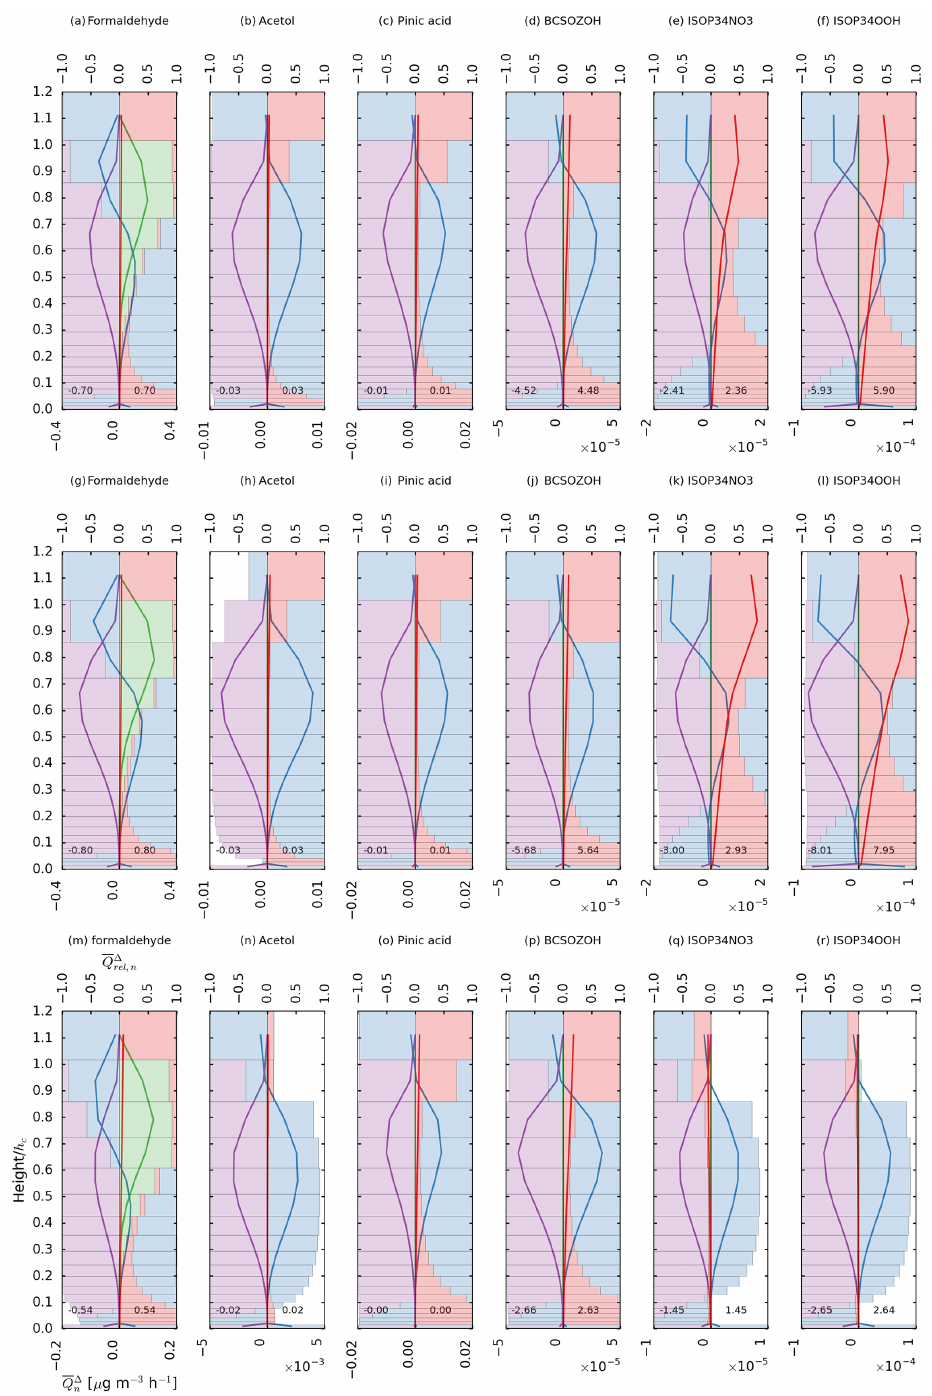
Figure 9. The same as Fig. 8 but for formaldehyde, acetol, pinic acid, BCSOZOH, ISOP34NO3, and ISOP34OOH. Note that the bottom numbers for BCSOZOH, ISOP34NO3, and ISOP34OOH also need to be scaled by 10 − 5 , 10 − 5 , and 10 − 4 ,